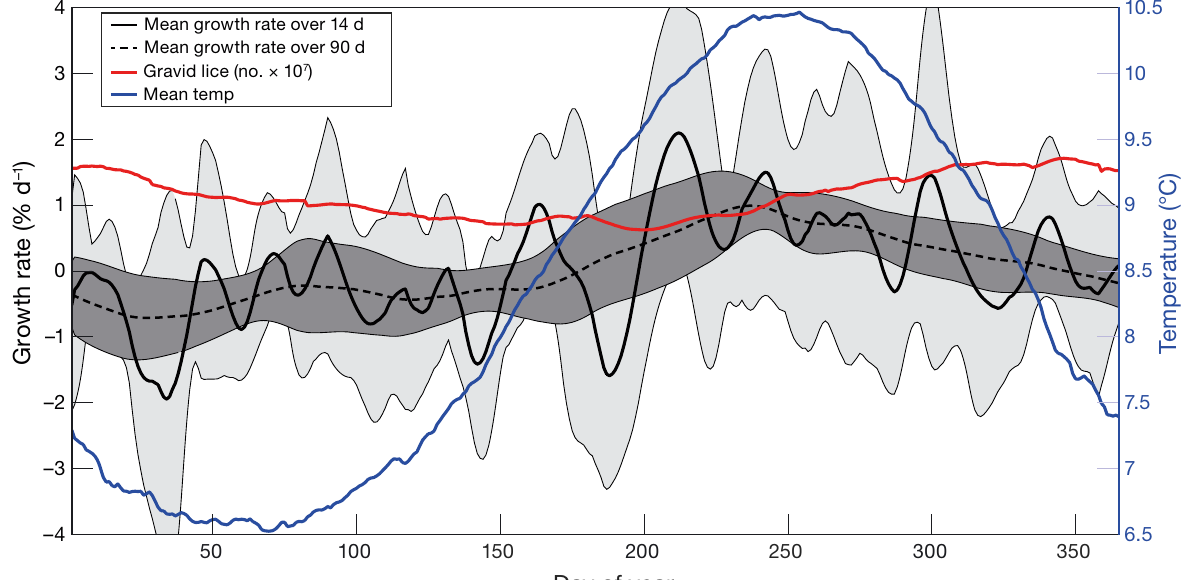
Fig. 6. Daily salmon-louse population growth rate of total Faroese gravid lice plotted by day of year averaged over 14 d and 90 d from 2011 to 2018, and total number of gravid lice. Light grey and dark grey shading indicate 95% CI for population growth rate averaged over 14 and 90 d, respectively. Daily annual temperature averaged for 2011 to 2018 is also shown